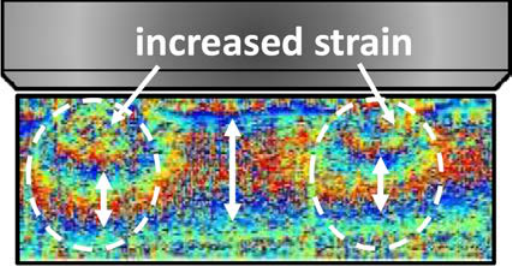
Fig. 3. An example of inhomogeneous strain distribution in a homogeneous silicone sample with an uneven surface (two protrusions). The dotted contours show the regions below the protrusions, where the phase gradient (and, therefore, strain) is signi¯cantly greater than in the central fairly °at region (the vertical arrows show the di®erence in the characteristic scales of the phase-variation periodicity between these